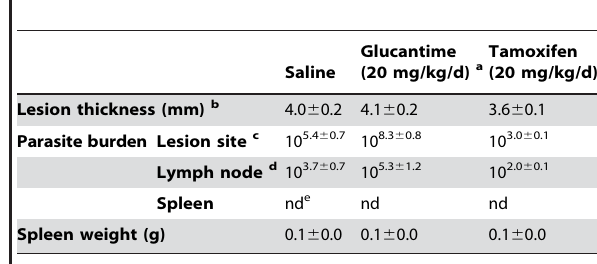
Table 1. Evaluation of disease progression and parasite burden in L. amazonensis -infected mice 3 weeks after the end of